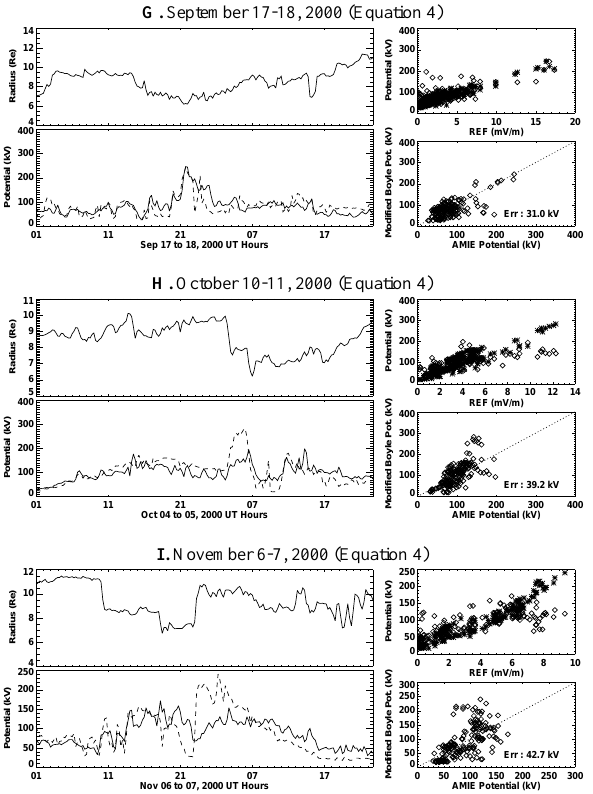
Fig. 7. The same three events in Figure 3, plotted in the same way as Figure 5.